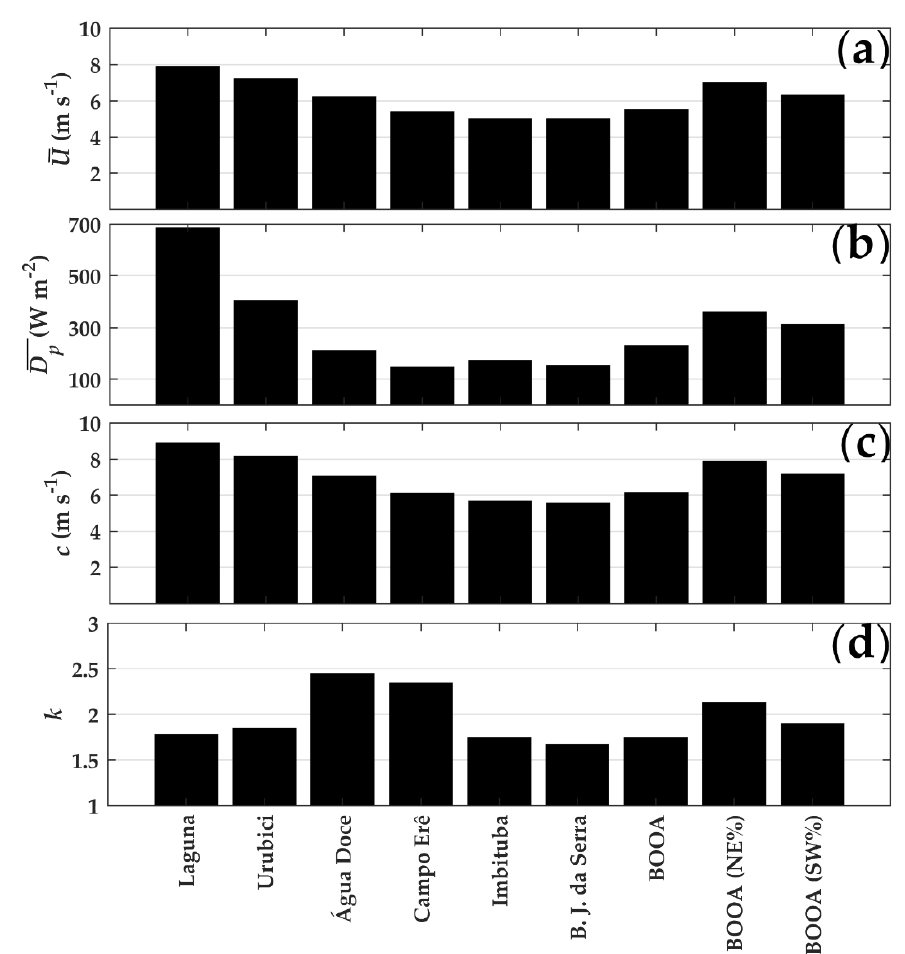
Figure 8. A comparison of BOOA winds with the wind resources estimated by the meteorological towers shown by Dalmaz (2007) [15]. BOOA LIDAR measurements are relative to 49 m in height, and most of the tower measurements have a height of 48 m. Only the Campo Erê measurements have a height of 30 m. BOOA (NE%) covers winds between 30° and 60°. BOOA (SW%) covers winds between −150° and −120°. ( a ) U ̅ is the horizontal wind speed (m s −1 ), ( b ) D p ̅̅̅̅ is the mean power density (W m −2 ), ( c ) c is the Weibull scale parameter (m s −1 ), and ( d ) k is the Weibull shape parameter. The mean values are shown in Table 5.